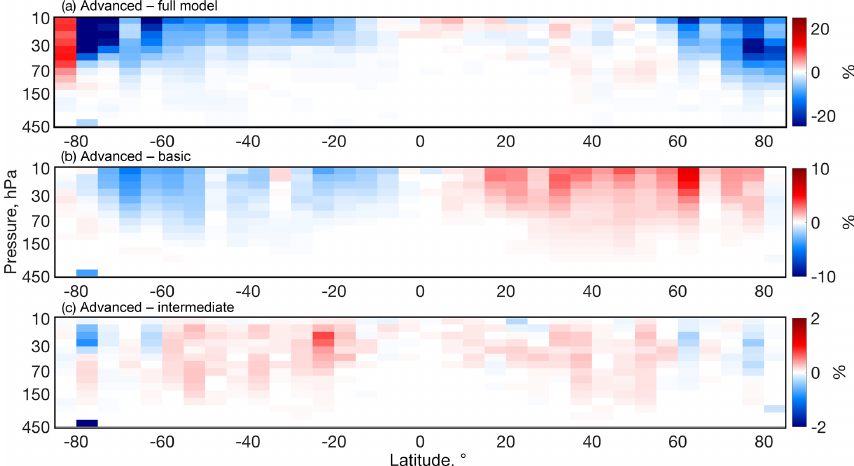
Figure 4. The comparisons of the three sampling methods described in the text using N 2 O simulations in CMAM30HR. The relative differ- ences (%) defined as the difference between the advanced sampling and (a) the full model output, (b) basic sampling, and (c) intermediate sampling, relative to the advanced sampling. Note the different colour scales in each